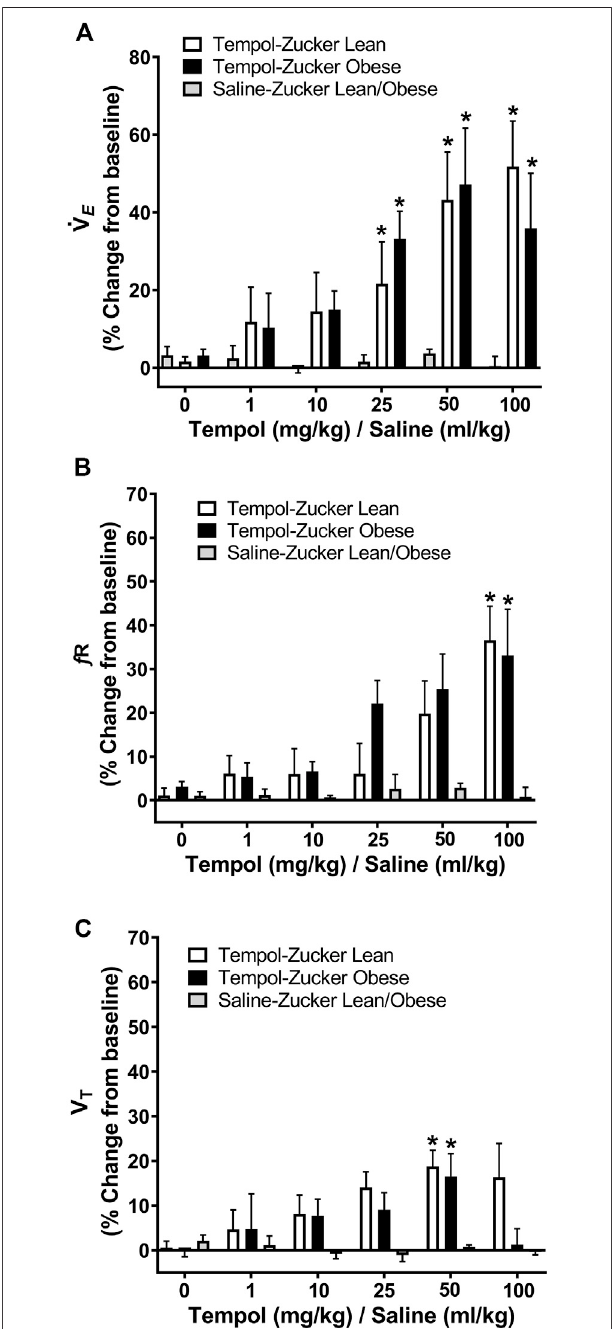
FIGURE 3 | Tempol enhanced breathing in iso fl urane-anesthetized obese and lean Zucker rats. Ventilatory parameters were measured by direct tracheal spirometry. Cumulative bolus doses of Tempol (1 – 100 mg/kg, IV) wereadministeredinlean(openbars)and obese( fi lledbars)Zuckerrats. Peak changes in minute ventilation, frequency of breathing and tidal volume was expressed as percentage change from baseline. Tempol dose- dependently increased minute ventilation (Panel A) mostly by its effects on respiratory frequency (Panel B) and partially by its effects on tidal volume (Panel C) . Repeated administration of equivalent volume of saline (time control,shaded bars)hadnoeffectsonoftheseparametersinleanandobese